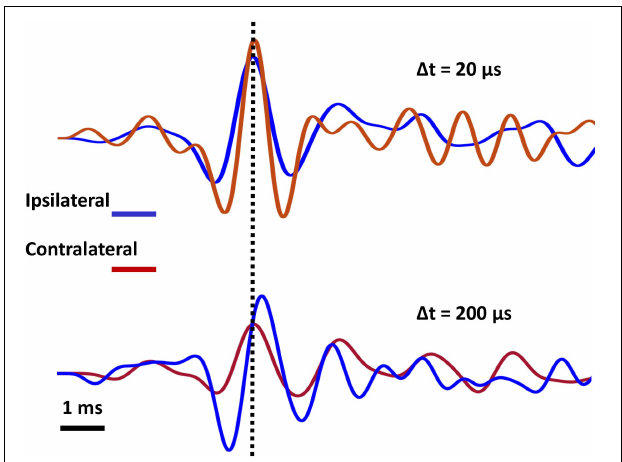
FIGURE 7 | Paired auditory nerve recordings for a stimulus source at 0 ◦ alone (upper traces) and in the onset-cancelation condition (lower traces). Auditory responses are nearly simultaneous for a forward source alone. In the onset-cancelation condition, ipsilateral responses (relative to the cancelation source) are delayed.